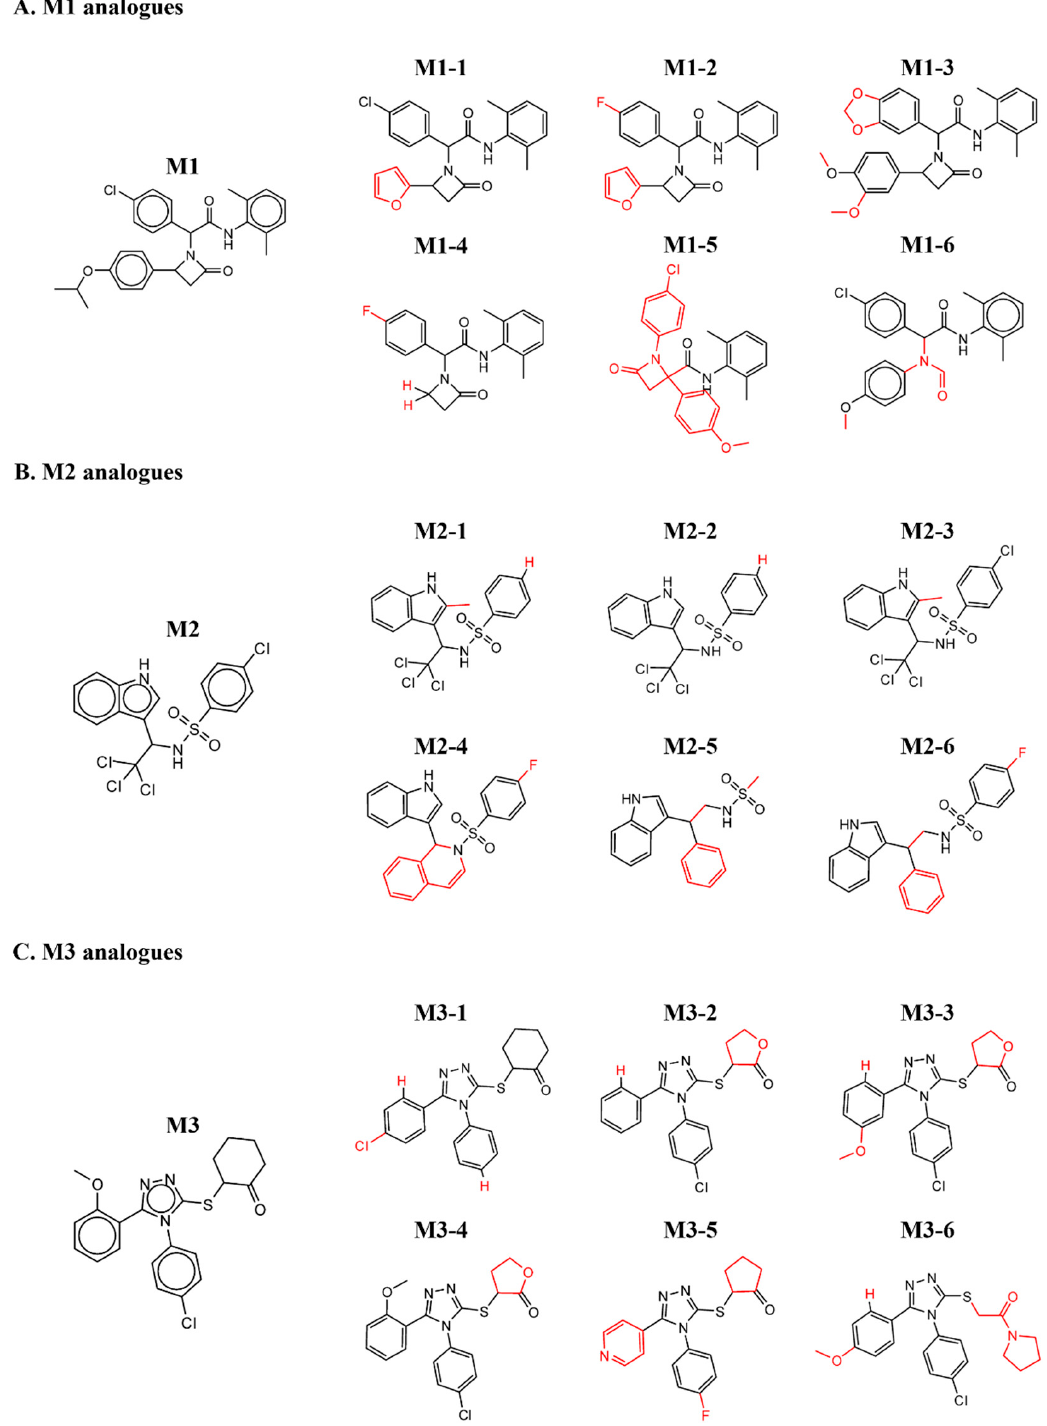
Figure 3. Chemical structures of analogues that were tested for binding to MDM2. The red color shows the substitutions that differ from the original hit.